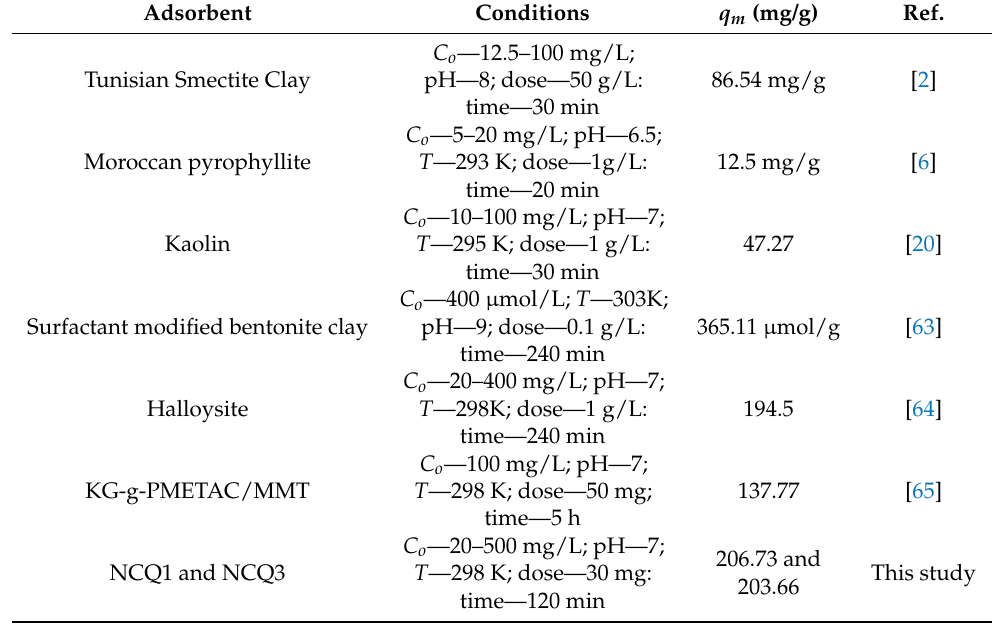
Table 7. Comparison of the CV adsorption capacity of both NCQ1 and NCQ3 adsorbent with other clay